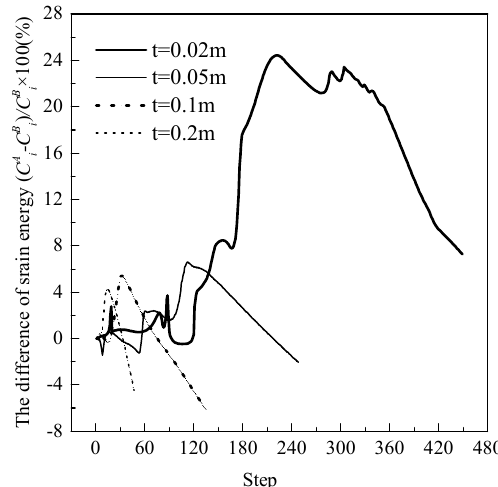
Figure 10. The difference of the strain energy between Scheme A and B at the same step for the different thickness t.